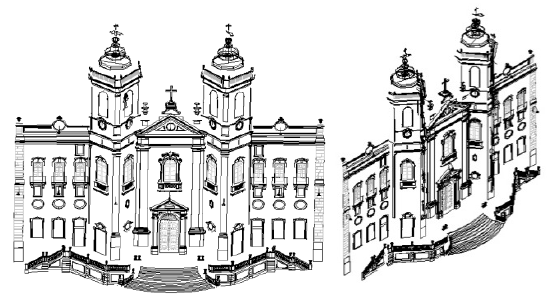
Figure 4. CAD 3D wireframe model of the Igreja de Nossa